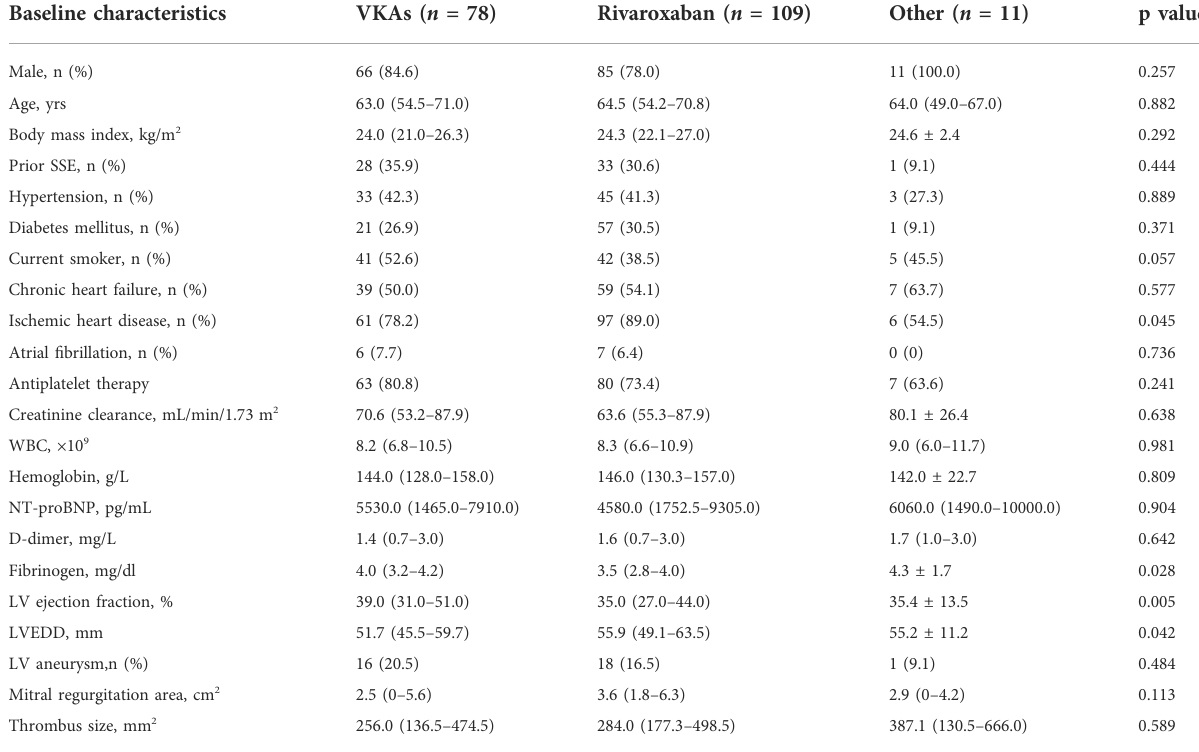
TABLE 1 Clinical characteristics in heart failure patients with LVT.